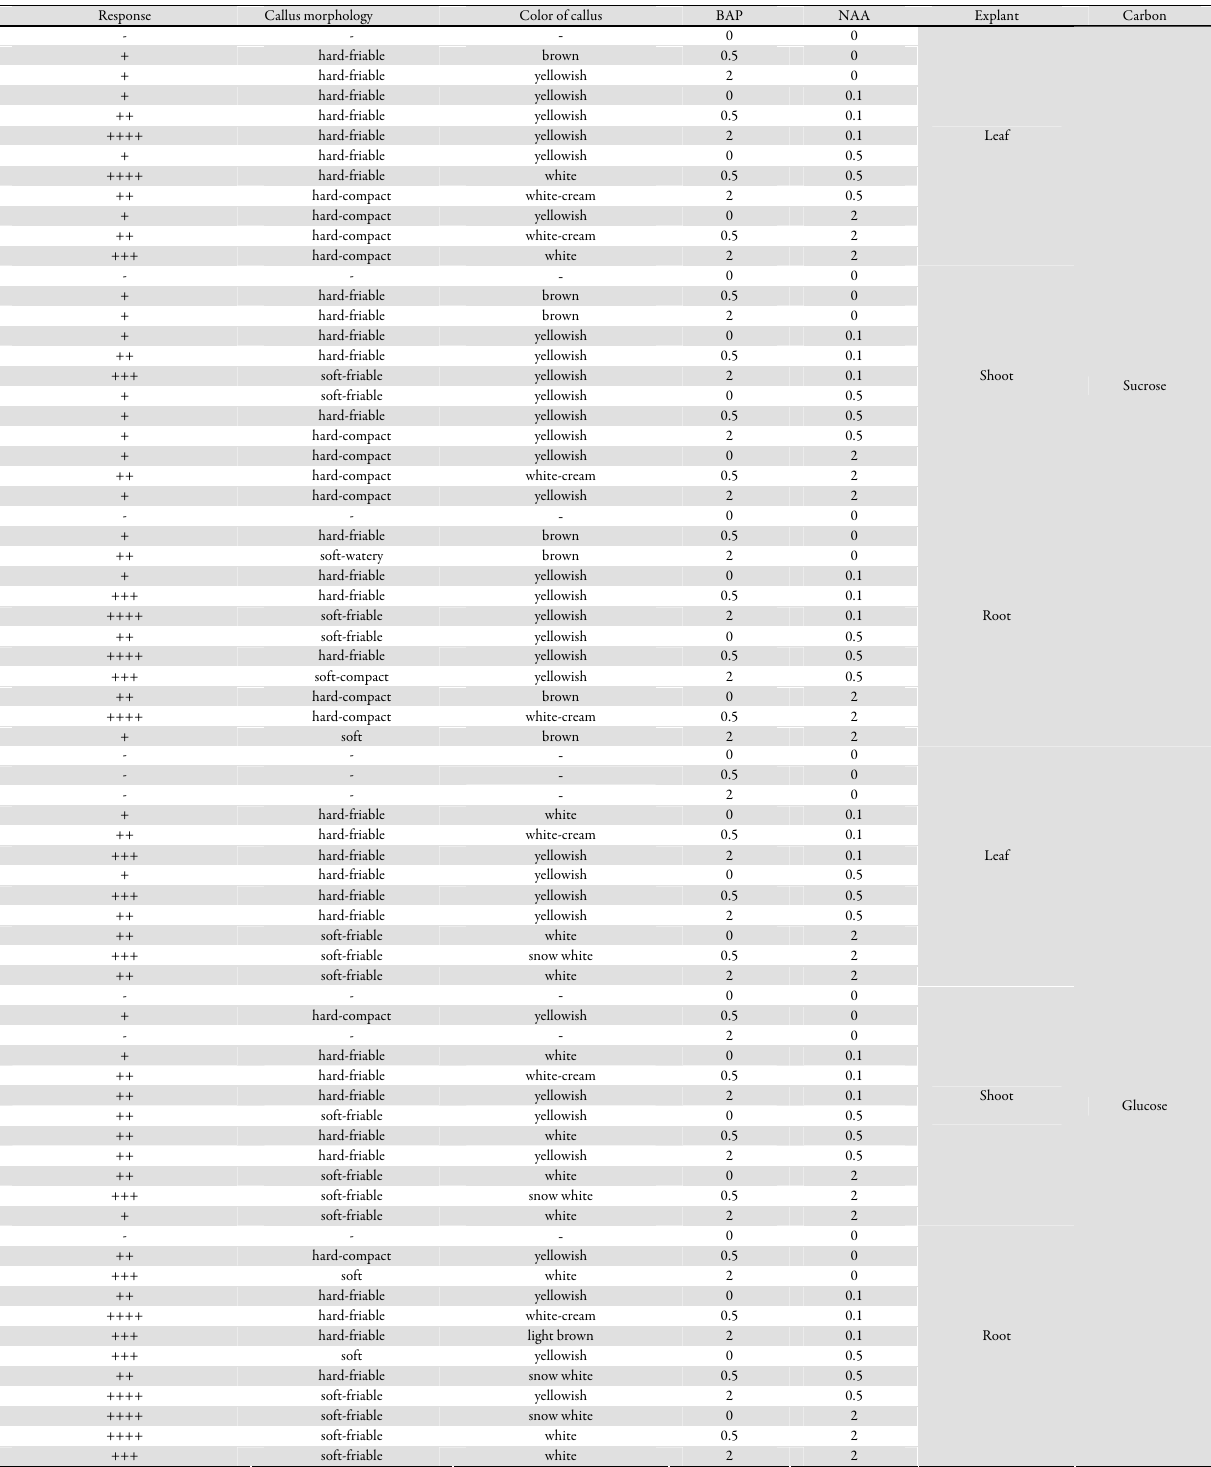
Table 1. The callogenesis response of A. annua different explants to various concentrations and combinations of growth regulators and carbon sources